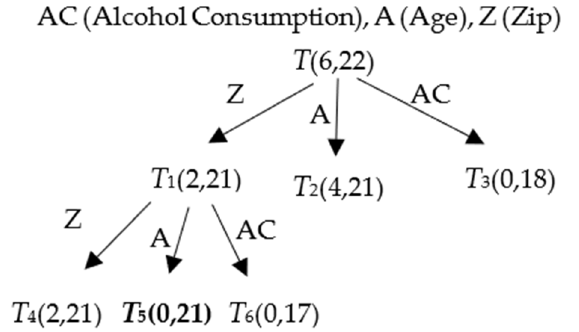
Figure 3. Complete Search Tree of our Approach.